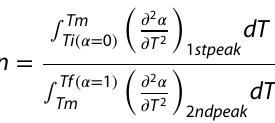
Table 2 Thermal decomposition parameters obtained by FWO method in the α range 5–20% for PP/MMT-IL nanocomposites 5%Content of E (kJ.mol −1 a organoclay (wt%)